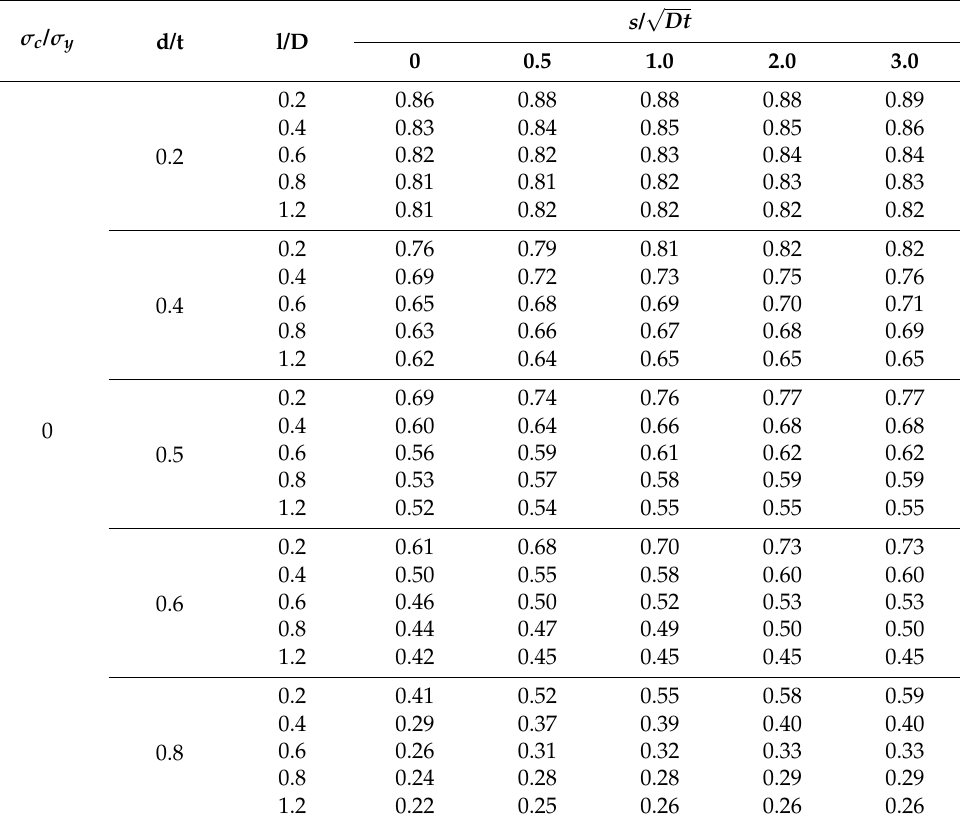
Table 5. FEA on corroded pipeline with longitudinally interacting corrosion defect (LID) subjected to internal pressure and 0 σ c / σ y longitudinal compressive